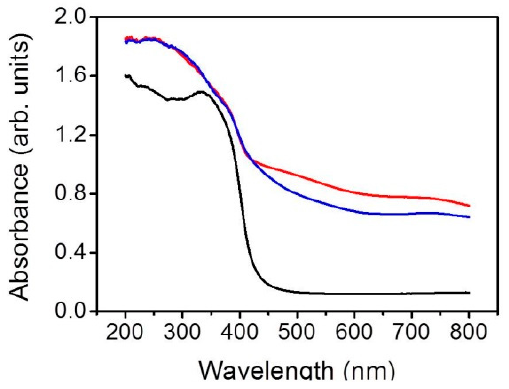
Figure 5. Optical absorbance spectra of the pristine TiO 2 (black), NST (blue), and NPT (red).